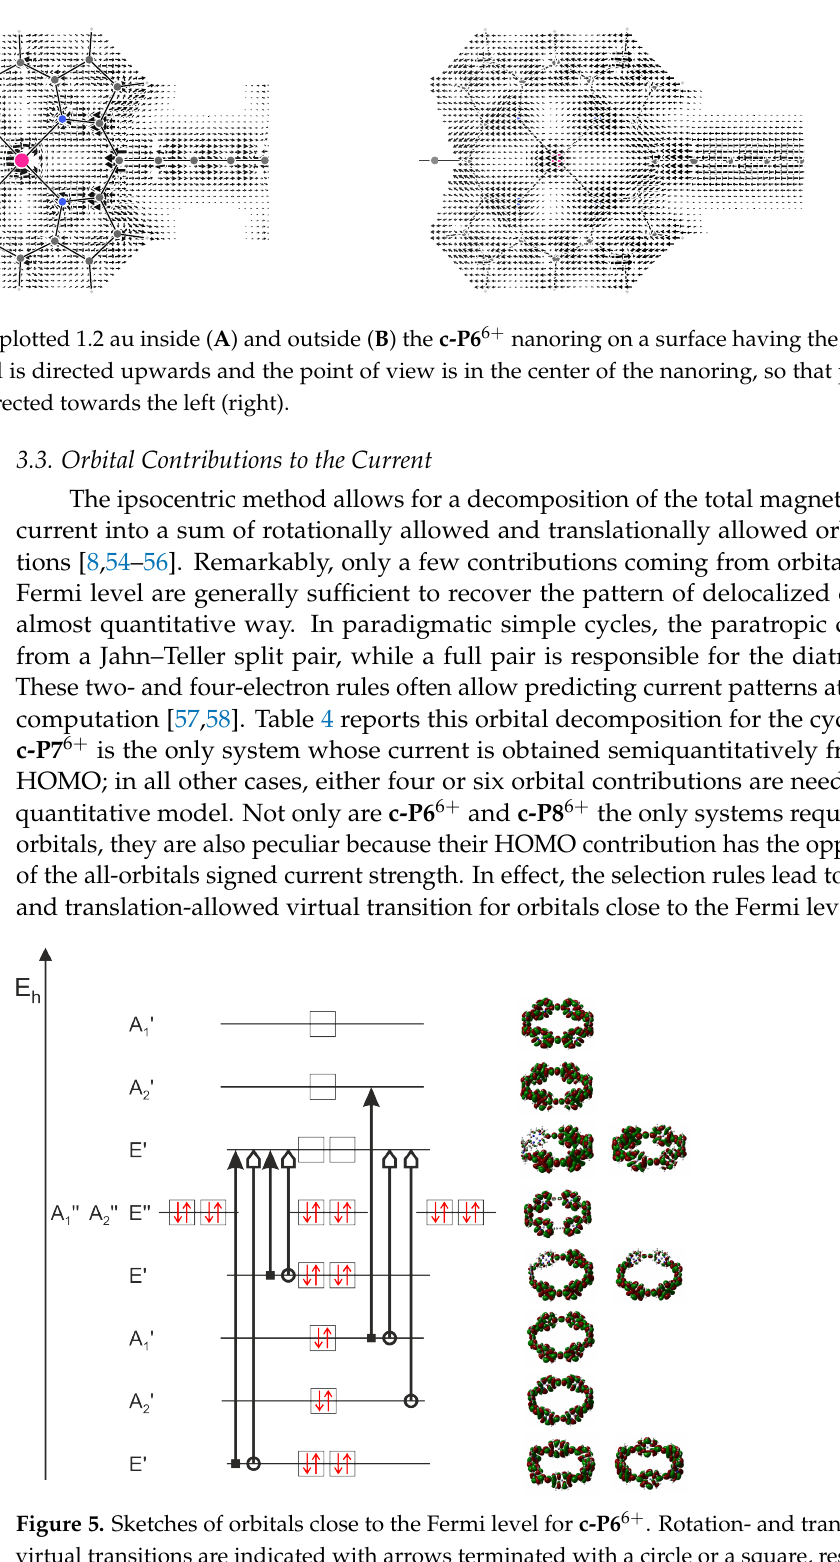
, A (cid:48)(cid:48) , and E (cid:48)(cid:48) is sketched for 2 1